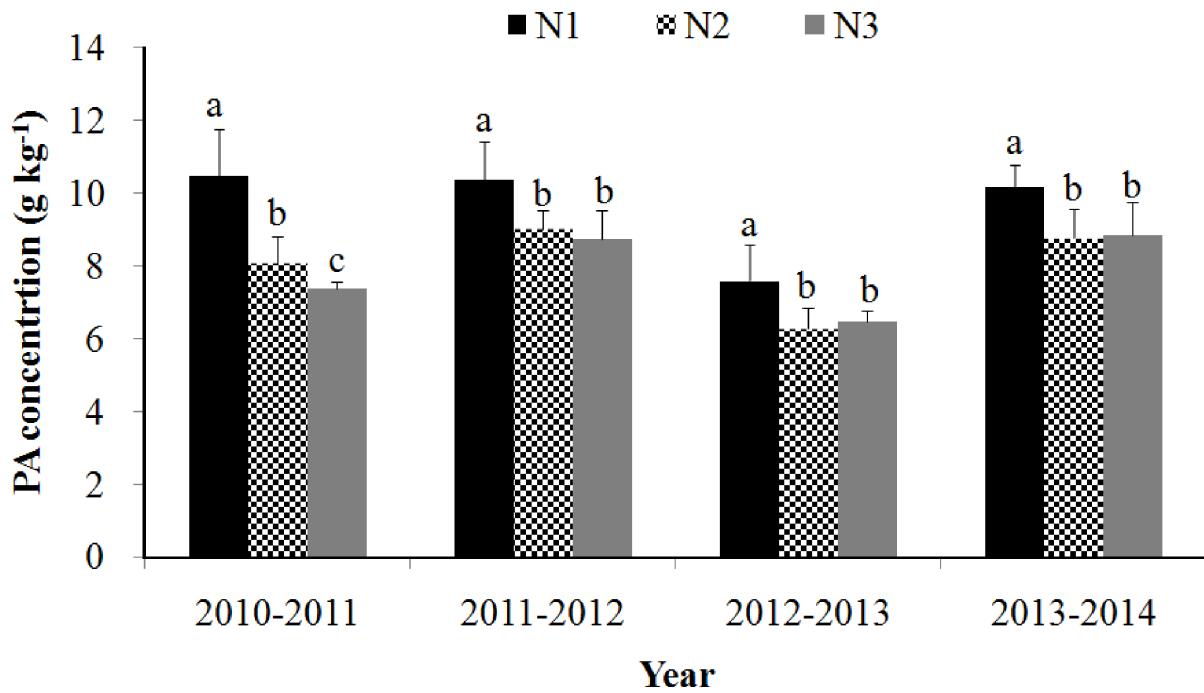
Fig 1. Grain PA concentration of winter wheat as influenced by soil N fertilizer rate (0 [N1], 120 [N2] or 240 [N3] kg N ha -1 ) under field conditions at Yangling during 2010–2011,2011–2012, 2012–2013and 2013–2014. PA: phytic acid. Error bars represent standard error (n = 20). Bars havingdifferent lowercaseletters are significantlydifferent ( P < 0.05). Because the effect of the foliar applicationwas not significantfor grain PA concentration, the mean grain PA of different foliar treatments for each cropping seasons and all the N rates are